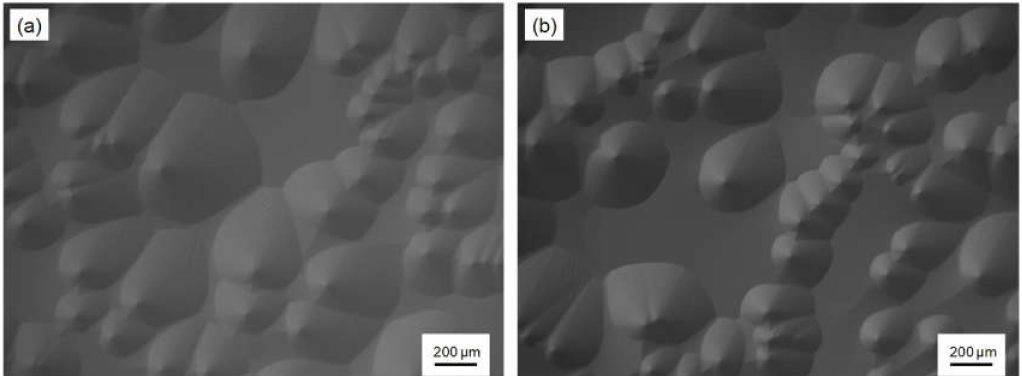
Figure 2. Nomarski optical microscopy (NOM) images of the on-axis 4H-SiC epitaxial layer surface grown ( a ) without and ( b ) with HCl addition. ( b ): The HCl flow rate was 540